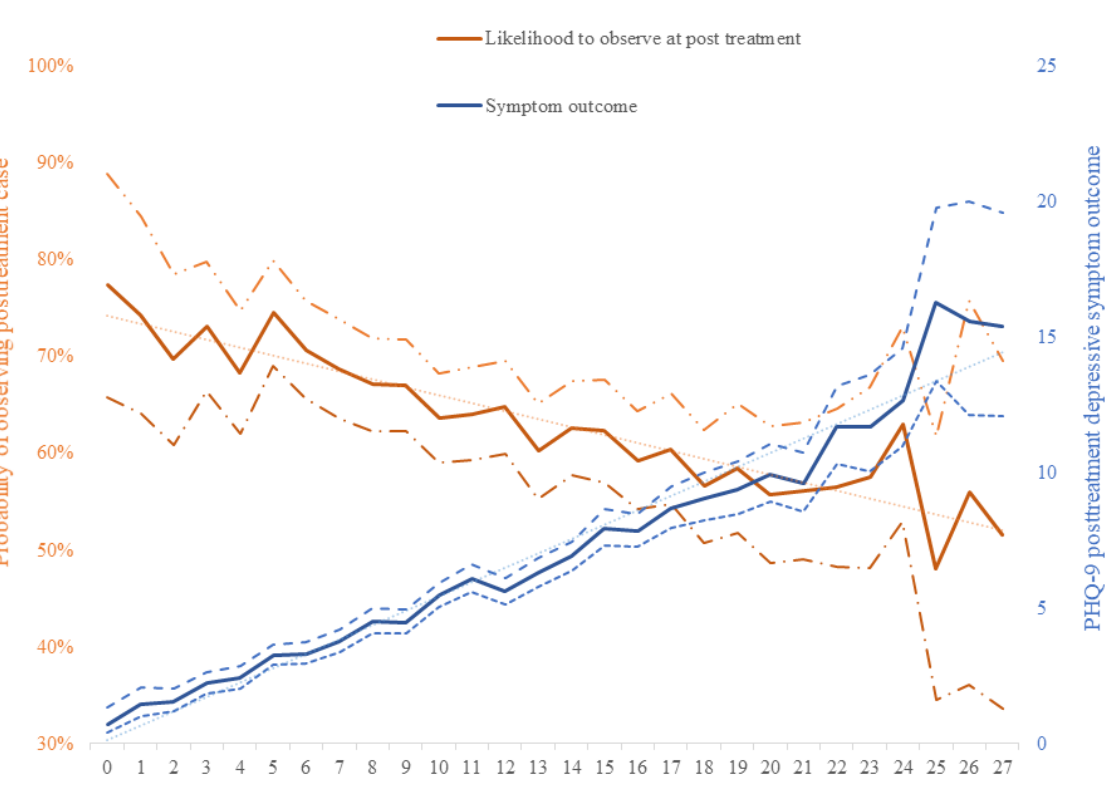
Figure 2. Probability for observing cases at posttreatment (inverse probability of missing cases) and treatment outcomes trends associated with depressive